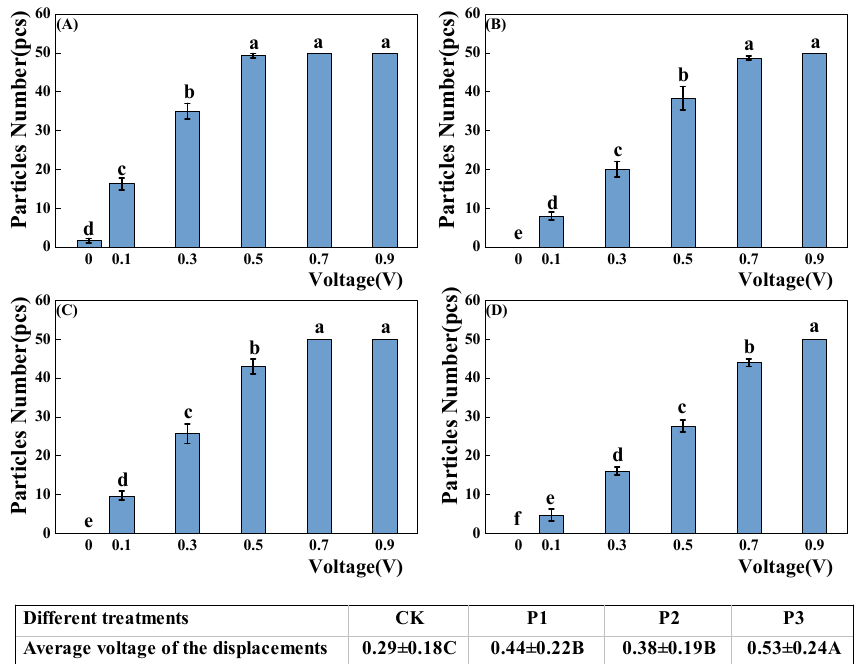
Figure 3. The number of soil particles displaced on mineral surfaces of indoor experiments. ( A ) The number of soil particles displaced at different voltages for the control group; ( B ) The number of soil particles displaced at different voltages for P1; ( C ) The number of soil particles displaced at different voltages for P2; and ( D ) The number of soil particles displaced at different voltages for P3. Different capital letters denote significant differences ( p < 0.05) between various treatments based on a one-way analysis of variance and the Duncan test. Different lowercase letters denote significant differences ( p < 0.05) between different voltages applied to the same